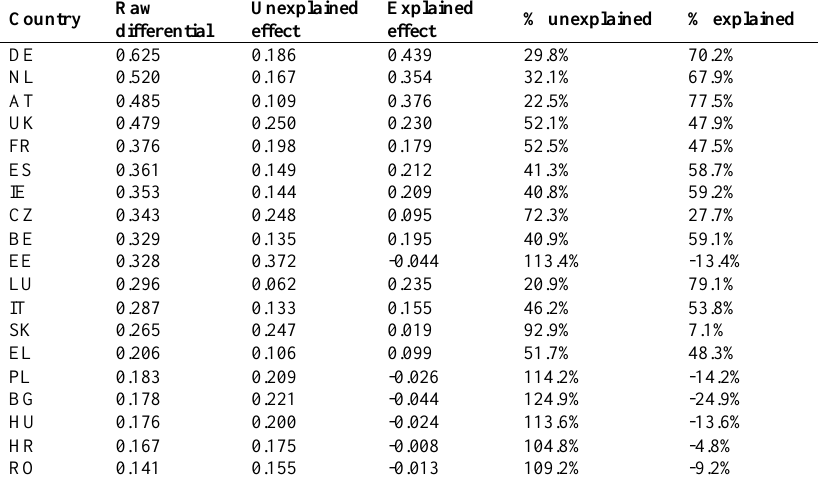
Table 2. The results of the aggregate Oaxaca-Blinder decomposition of gender pay gap in selected countries Raw Country differential